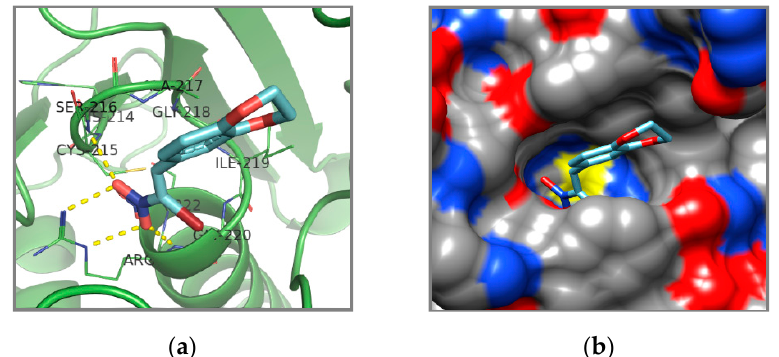
Figure 5. Docking result of compound 6 in the PTP1B catalytic site. ( a ) Key residues surrounding 6 ; ( b ) Binding pose of 6 . The colors represent the element or atom (Red: Oxygen; Blue: Nitrogen; Yellow: Sulphur; Orange: Phosphor; Green: Carbon of the receptor residues; Cyan: Carbon of ligand; Dotted Yellow line: Interaction between the atoms).